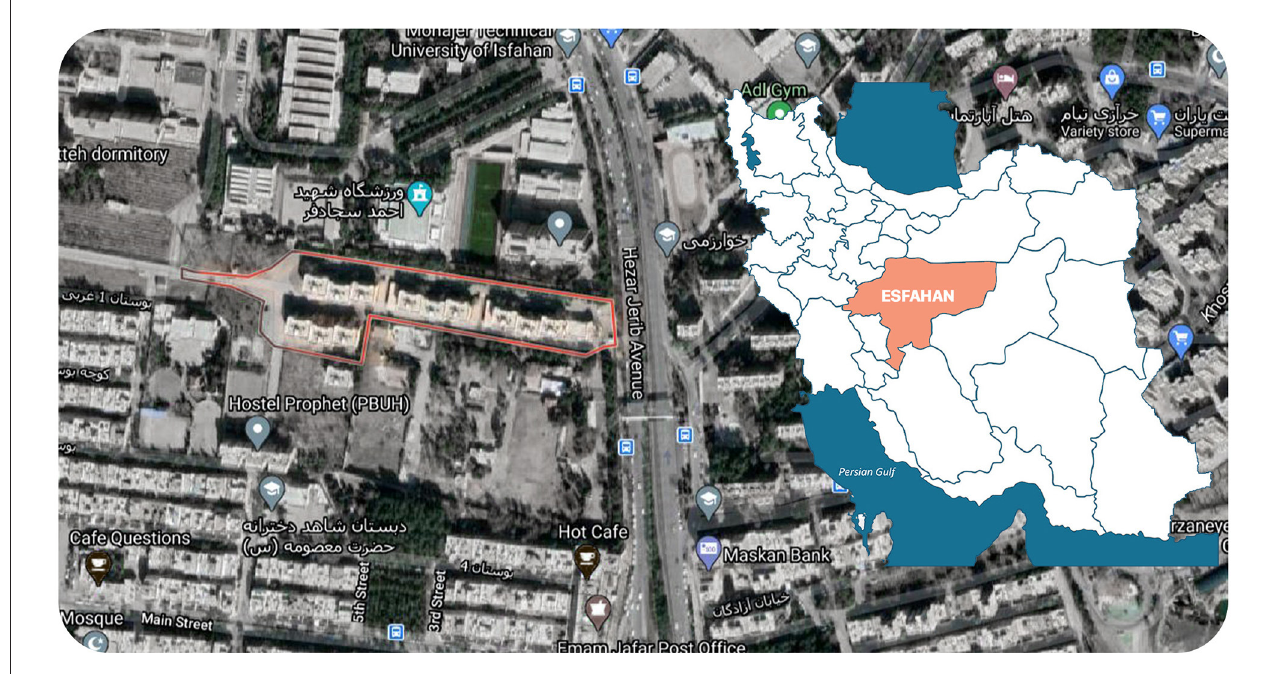
FIGURE 2 | The location of investigated